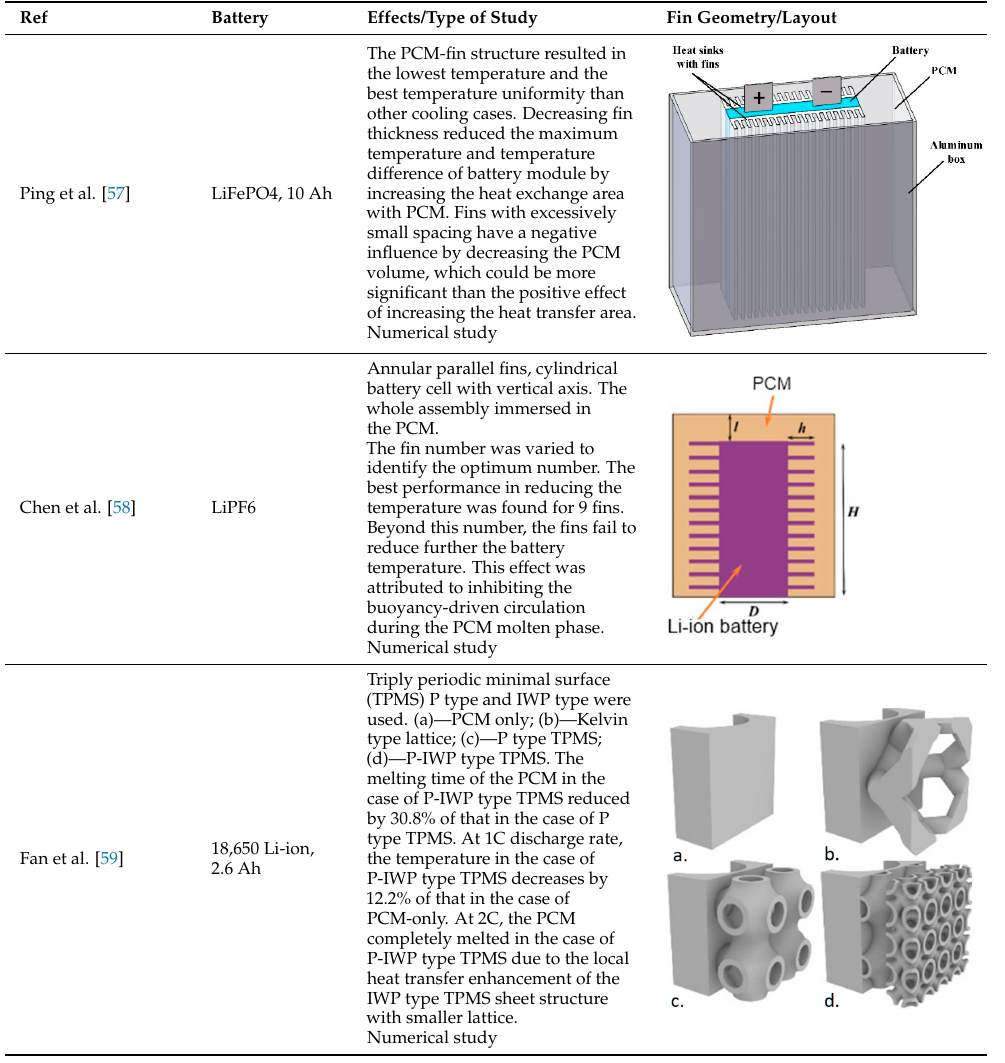
Table 3. Fin shapes and layouts for PCM-based